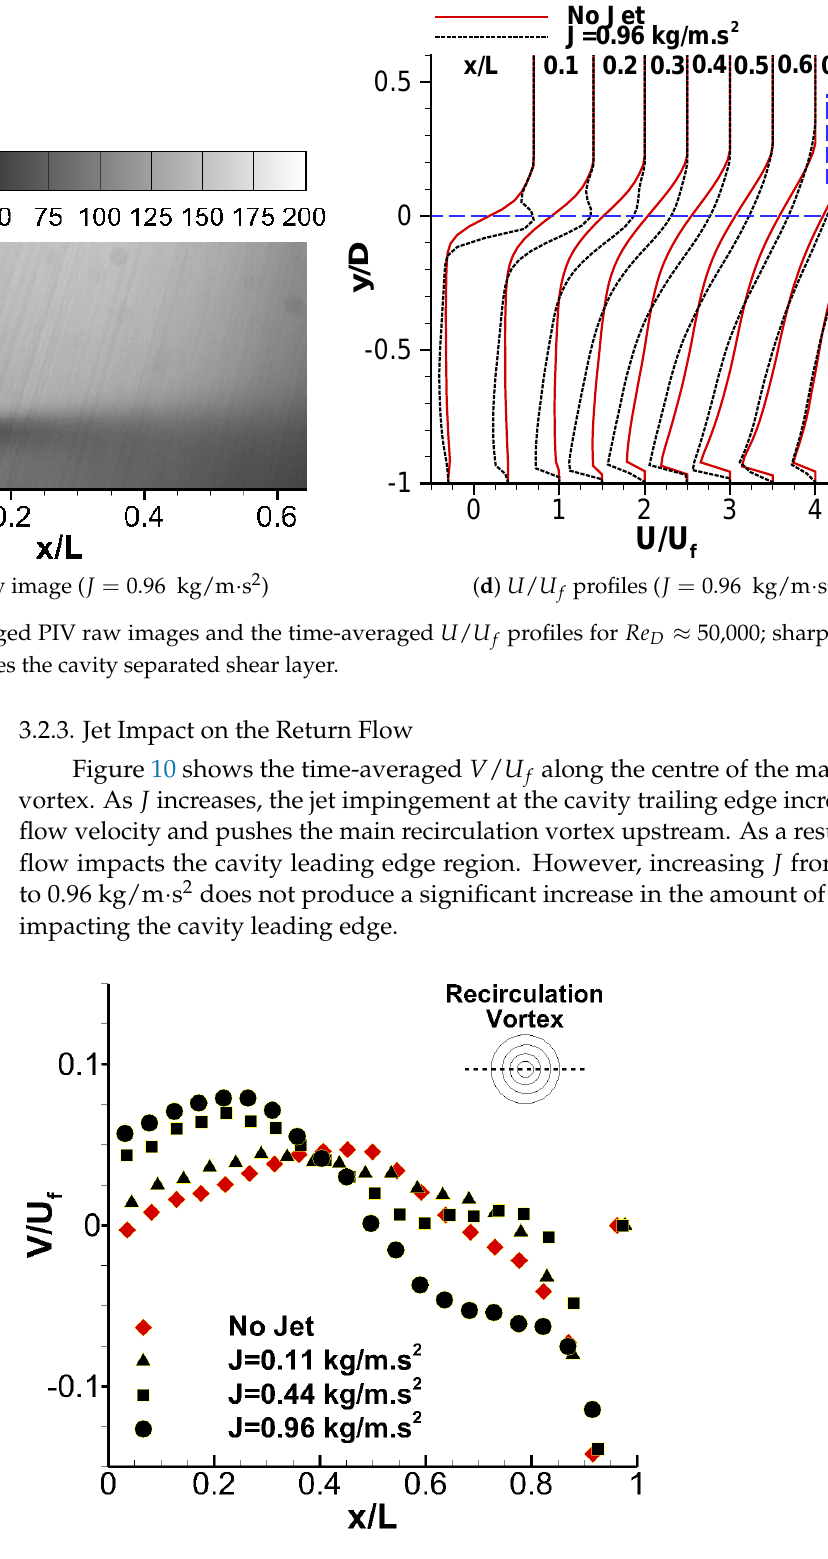
Figure 10. Profiles of the time-averaged V / U f along the centre of the main recirculation vortex for Re D ≈ 50,000; sharp edge at LE; different J